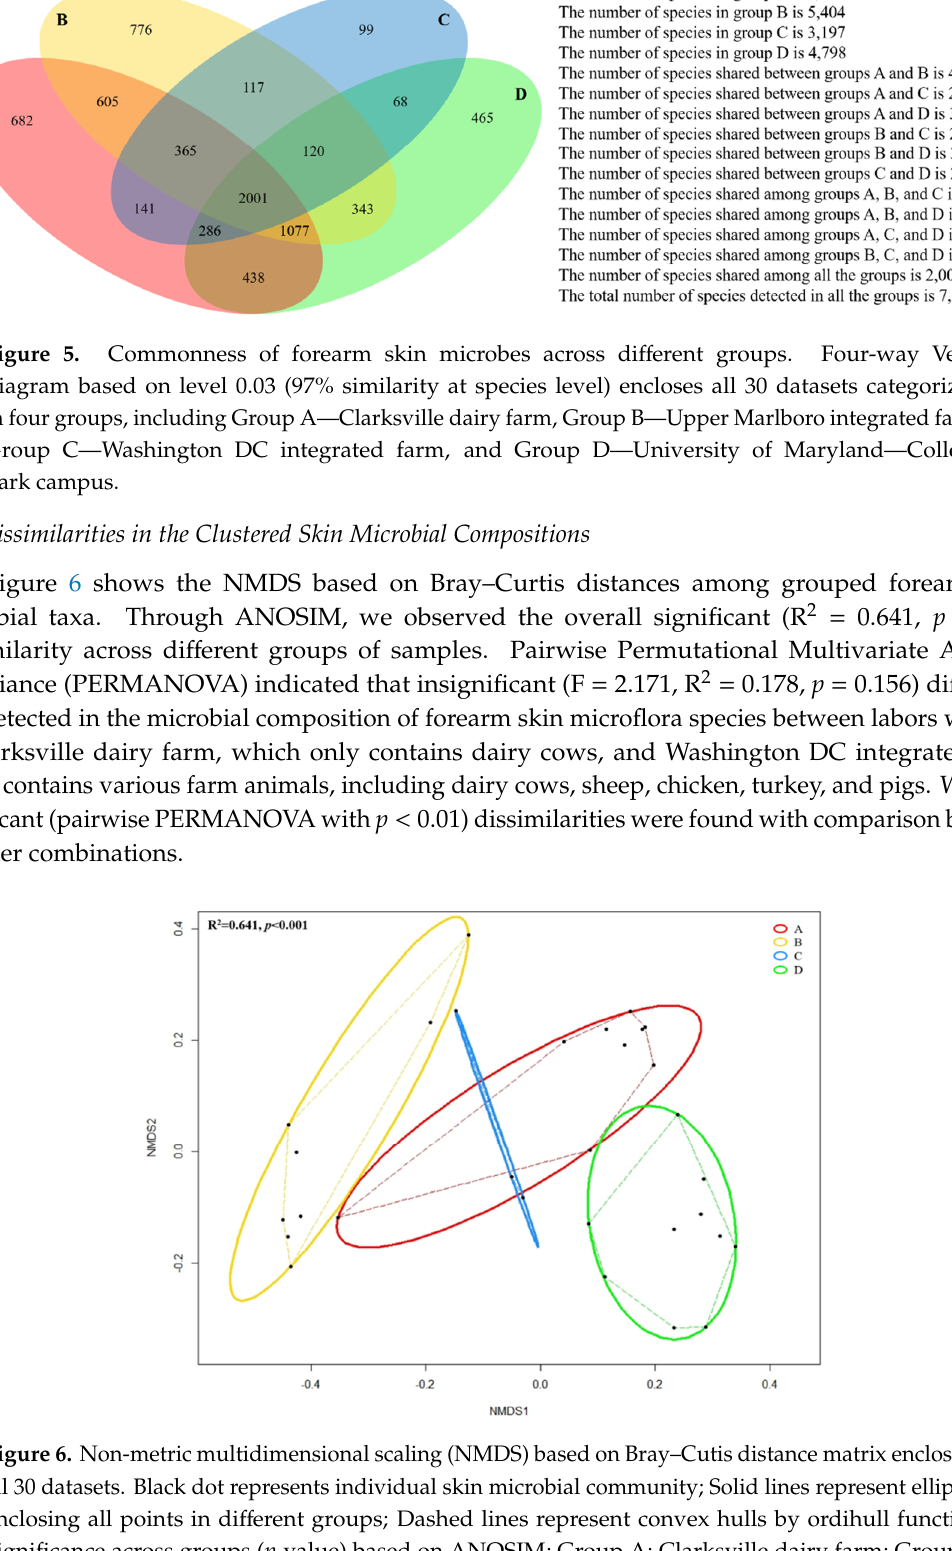
Figure 4. Dendrogram for phylogenetic distance of forearm skin microbiome. Clusters I, II, and III were predicted and classified among forearm skin microflora from various sample sources based on Newick Standard. The square represents skin sample #1 as an outlier. The scale bar unit represents 0.1 Phylip distance index value between the two samples.